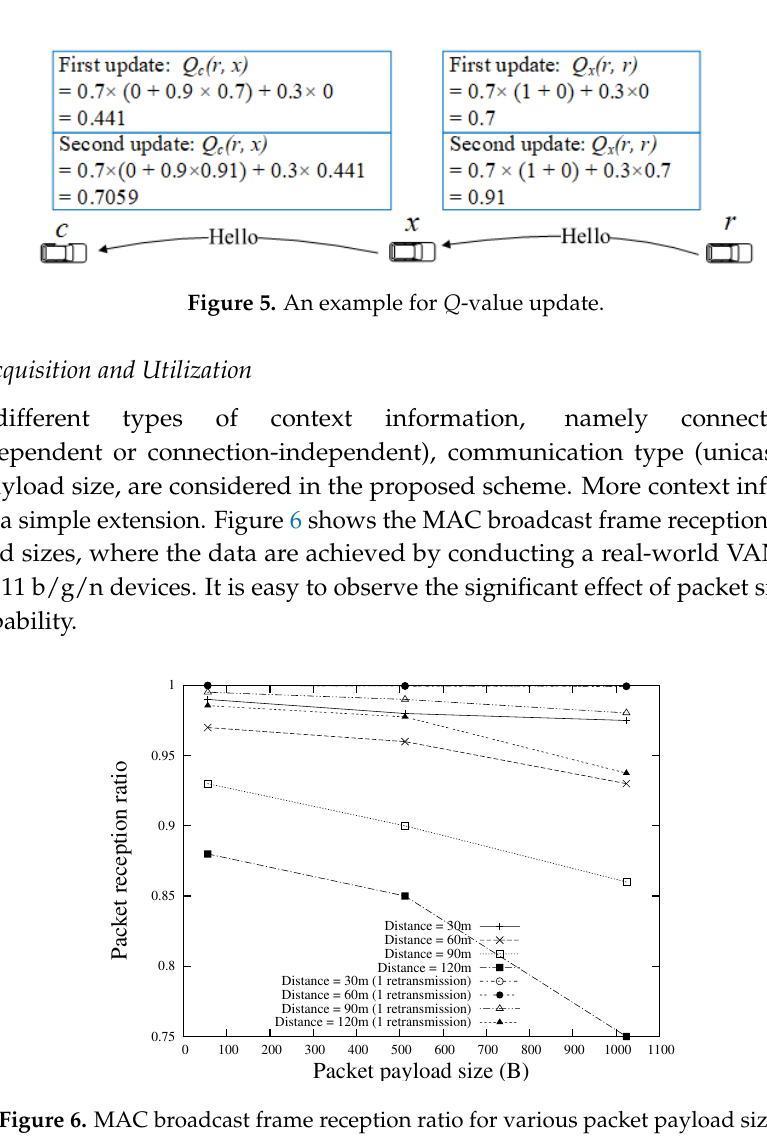
Figure 6. MAC broadcast frame reception ratio for various packet payload